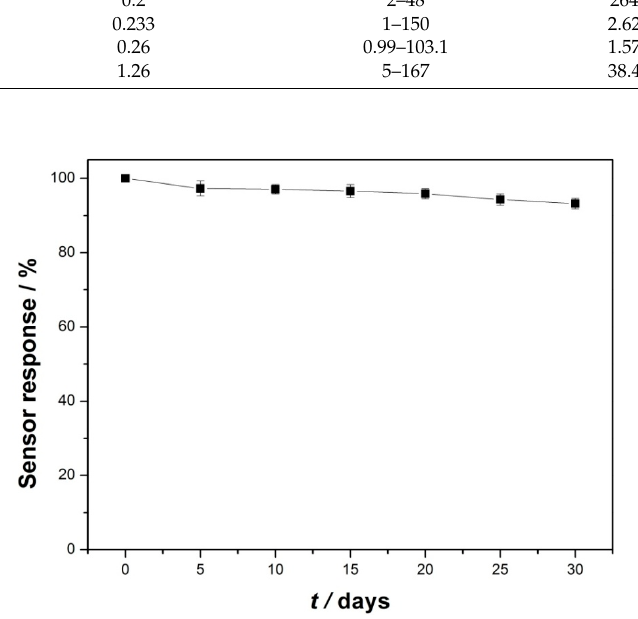
Figure 9. Storage stability of the GCE/Lac-PdBC-Nafion in pH 7.0 PBS at 4 °C.